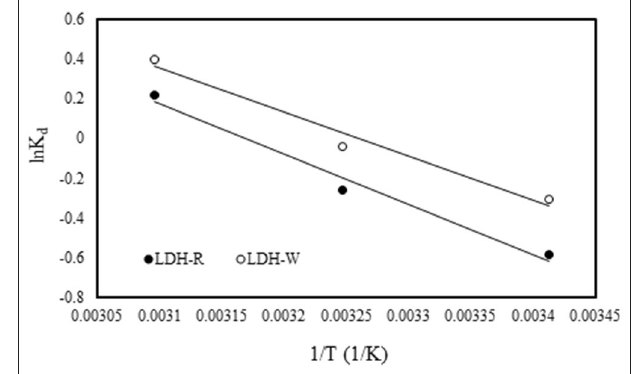
FIGURE 9 | Effect of temperature on the adsorption of Orange II onto the studied materials.